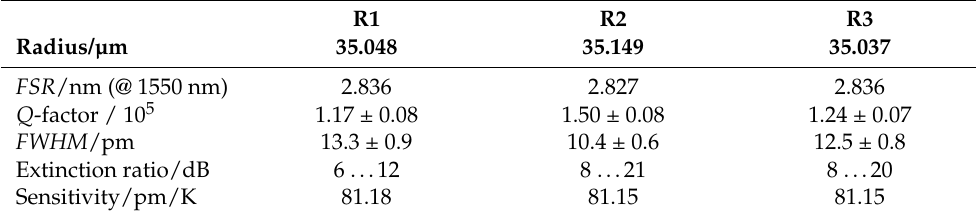
Table 1. Summary of the determined characteristics of the 126 resonances of each resonator in the wavelength range from 1530 nm to 1560 nm. For the Q -factor and FWHM , the mean value and its standard deviation are given for the individual